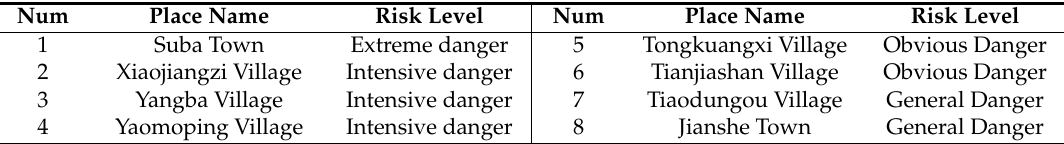
Table 11. The risk level of flood-affected